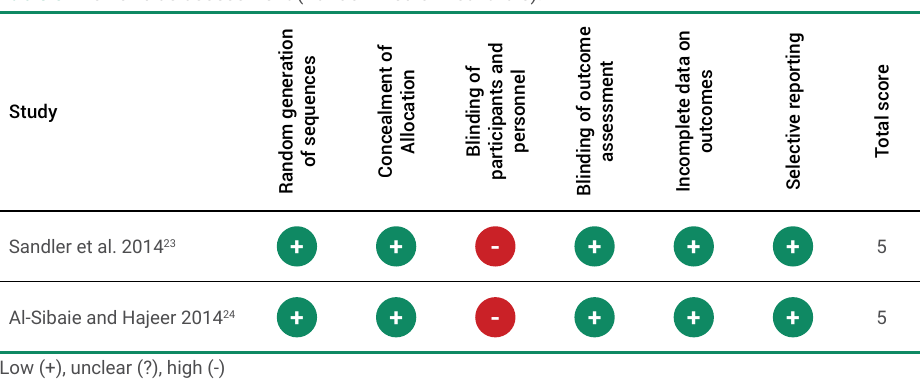
Table 3. Risk of bias assessment (Randomized clinical trials).